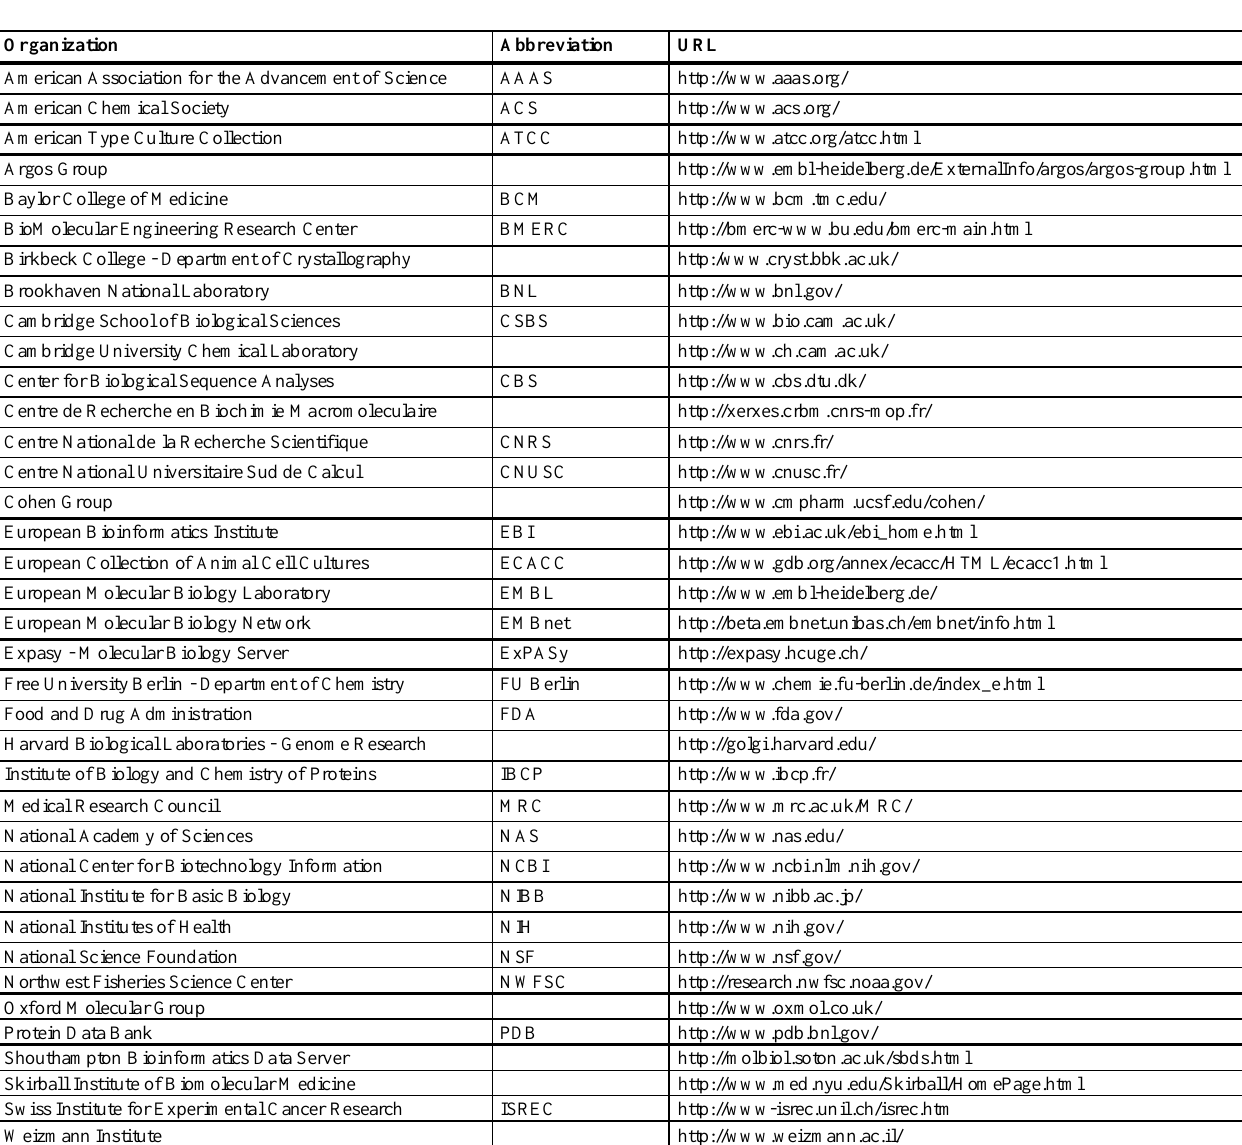
Table 3 - Reference organizations.